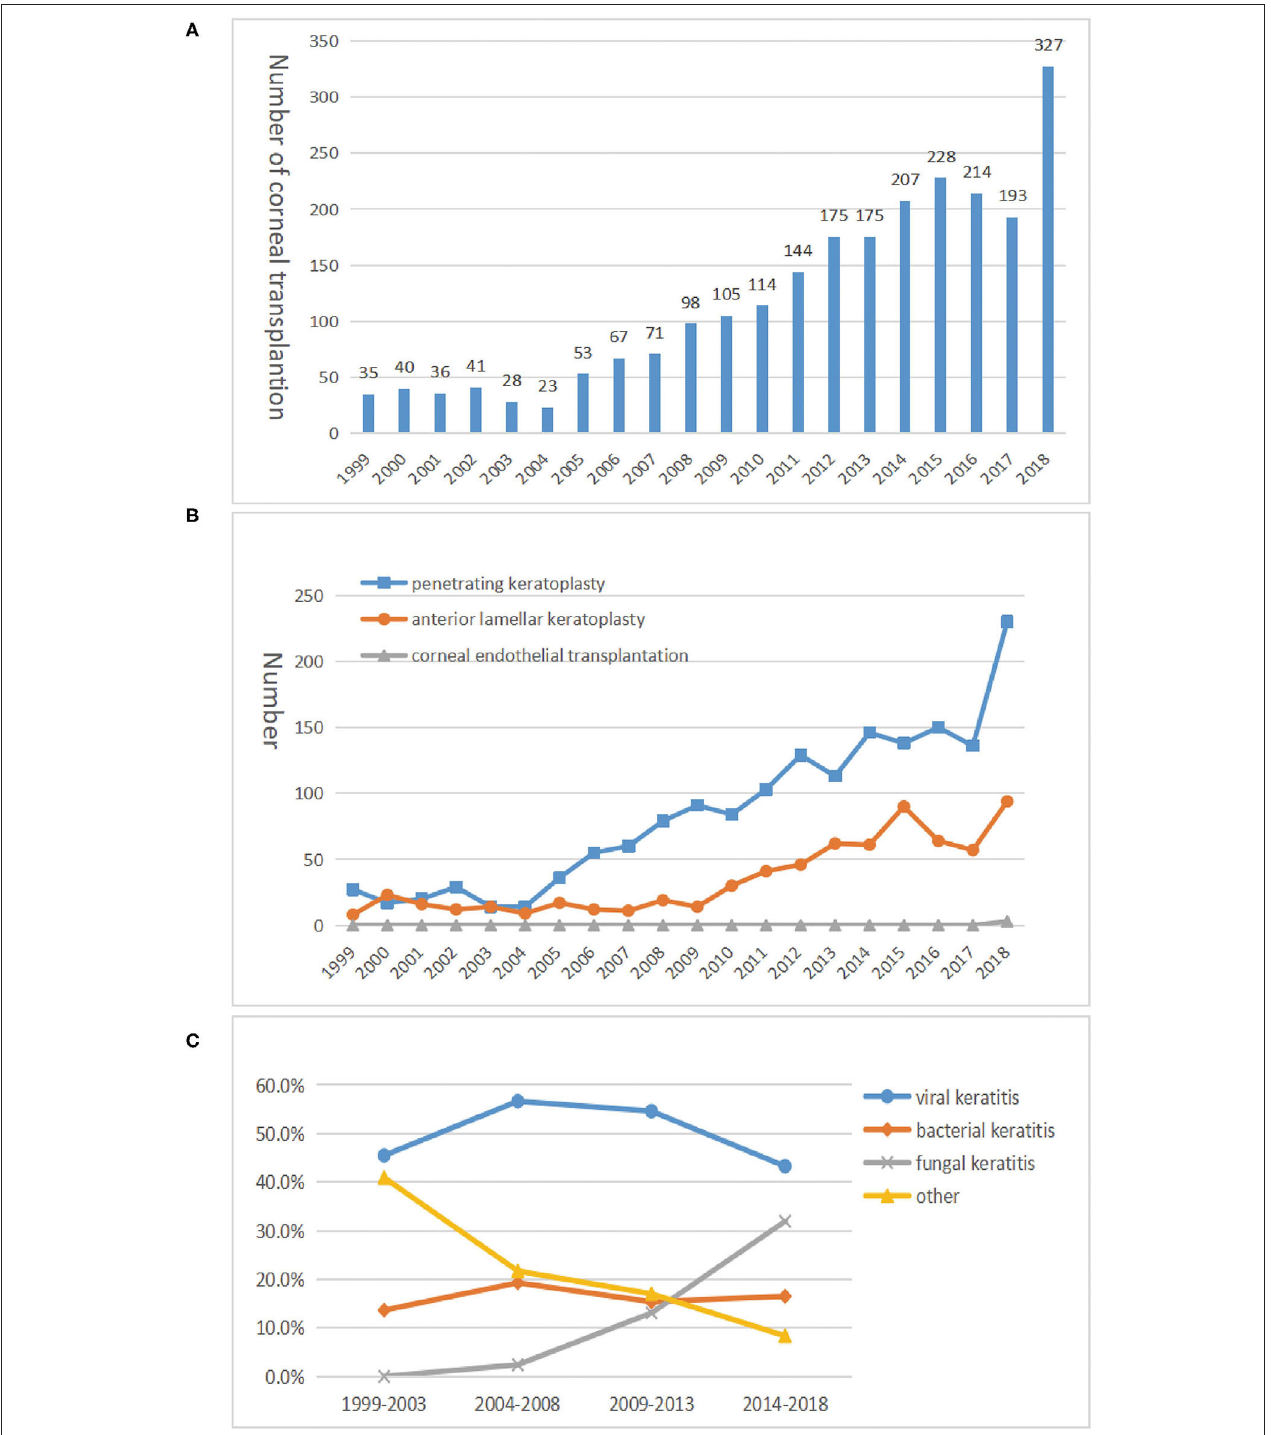
FIGURE 4 | The trend of corneal transplantation from 1999 to 2018. (A) The tendency of corneal transplantation numbers. The tendency of 2,540 corneal transplantations showing a significant upward trend from 1999 to 2018. Among these corneal transplantations, 2,374 (93.5%) were done at the Department of Ophthalmology of the First Affiliated Hospital of Chongqing Medical University, and the rest ( n = 166, 6.5%) were performed in other centers. (B) Number of procedures by the three corneal transplantation techniques in each period. Three corneal transplantation techniques indicate penetrating keratoplasty, anterior lamellar keratoplasty, and corneal endothelial transplantation. (C) The proportion of infectious keratitis in each period. Infectious keratitis indicated fungal, viral, or bacterial keratitis and others, and they were in the acute stage. Others represent cases where the clinical manifestations are strongly suggestive of an infectious lesion, but the culture results or blood testing were